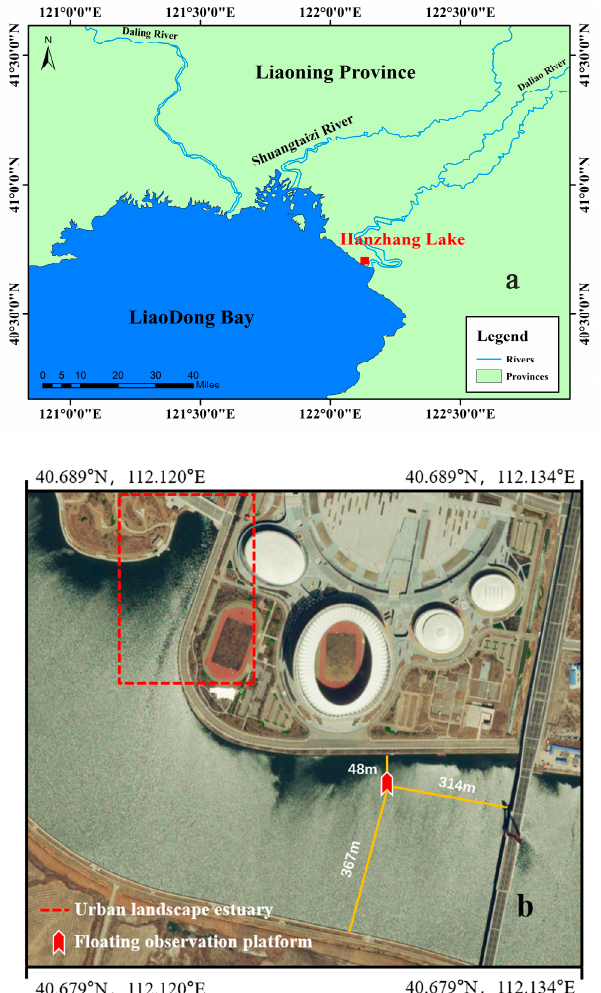
Figure 1. Study site and the floating observation platform (( a ) Hanzhang Lake sampling point; ( b ), floating observation platform). The study sites are marked by solid lines.